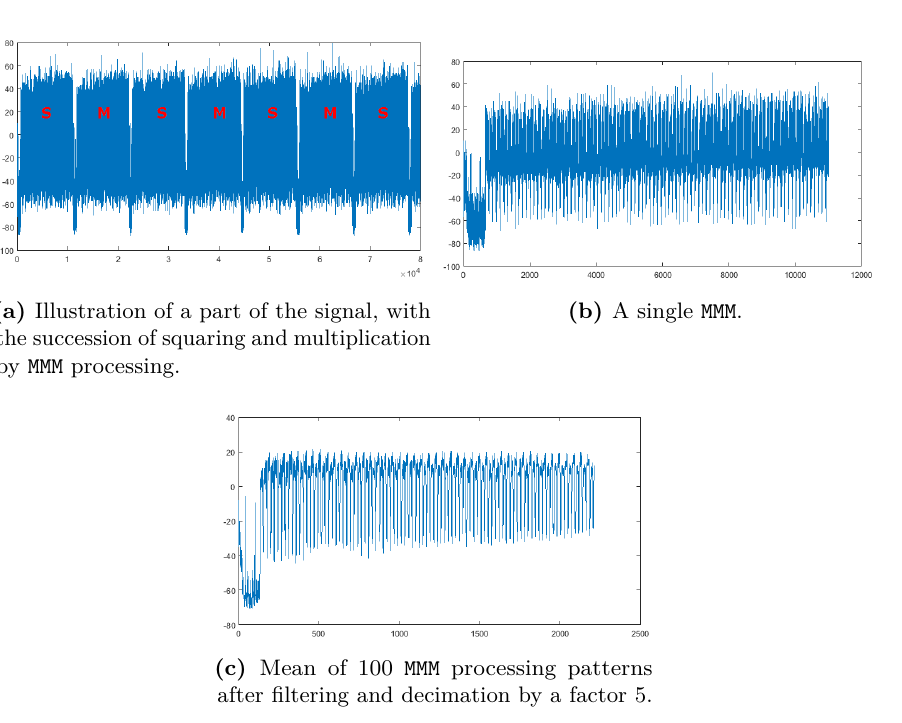
Figure 2: Alignment steps of the MMM processing